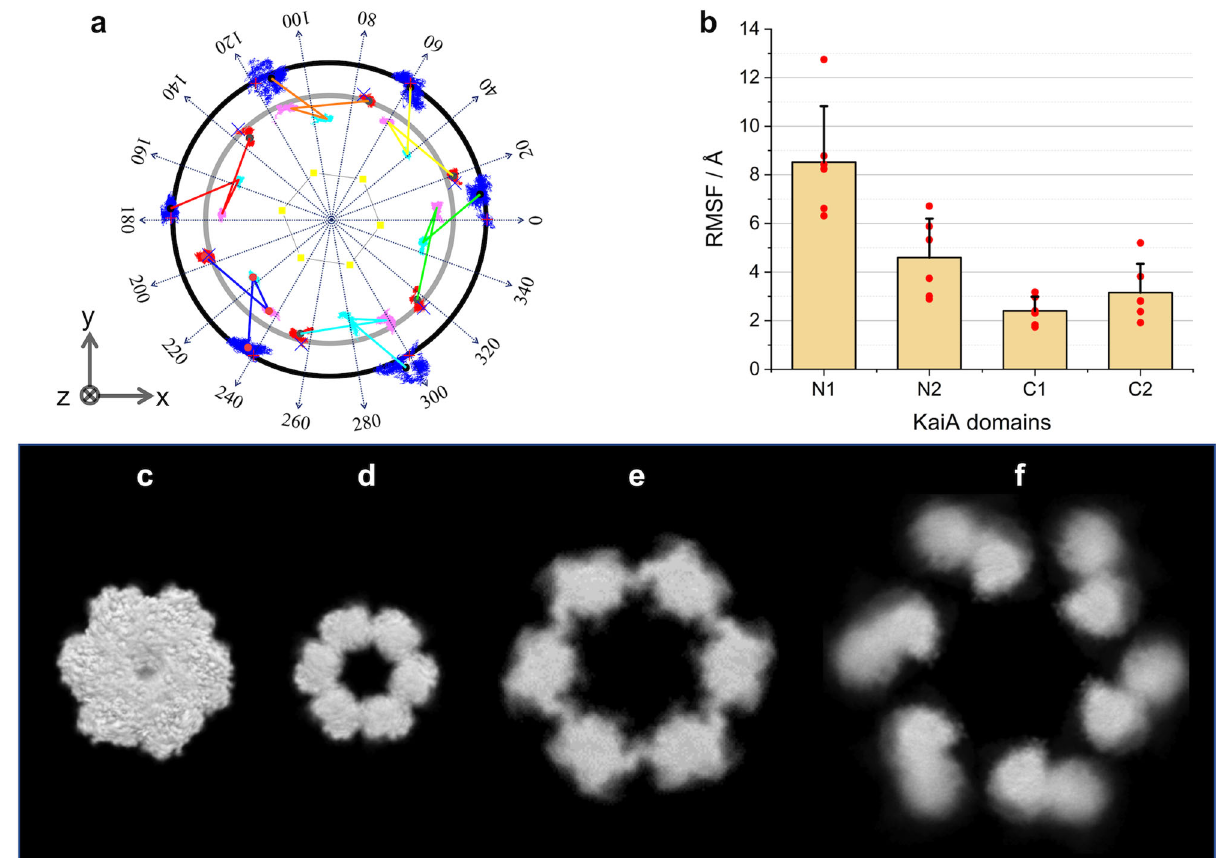
Fig. 6 Dynamical fl uctuations of domains in A 12 B 6 C 6 complex (Model III-2). a Trajectories of the A 2 domains. Blue, red, cyan magenta correspond to COMs of N1 A, N2 A, C1 A, and C2 A domains, respectively. Yellow dots express COMs of KaiB domains. Crosses show the initial positions in the 100 ns MD simulation. b The red points depict RMSFs of COMs of KaiA domains: Each N1 A, N2 A, C1 A, and C2 A has six domains. The thick orange bars show the averaged RMSFs with the error bars. Overlayed images in 100 ns MD simulations for c C 6 , d B 6 , e 12 C A domains, and f 12 N A